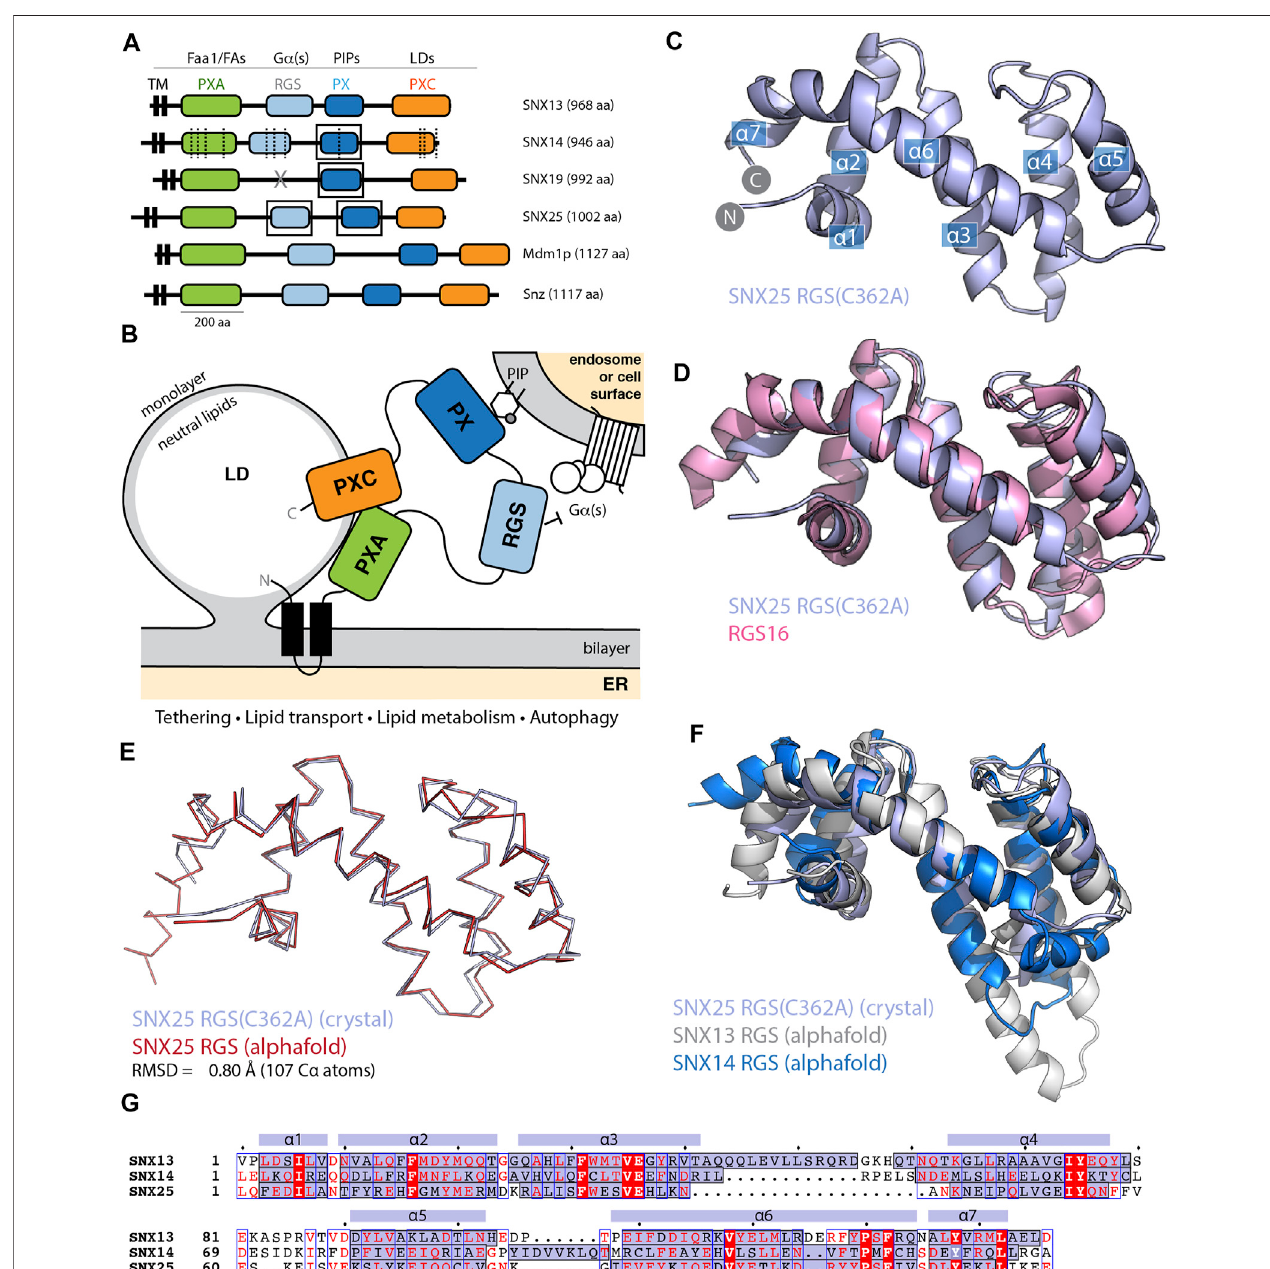
FIGURE 1 | The SNX-RGS protein family. (A) Domains of human, Drosophila , and S. cerevisiae SNX-RGS family members. Putative ligands for each domain are indicated above. SNX14 mutations causing cerebellar ataxia are shown with dashed lines (Thomas et al., 2014; Akizu et al., 2015). Boxes indicate domains with experimental structures determined. (B) The current working model for the architecture, localisation and function of the SNX-RGS protein family and their potential roles at the interface between the ER, LDs, and membranes of the endolysosomal system. (C) Crystal structure of human SNX25(C362A) RGS domain in cartoon diagram. Helical secondary structure elements are indicated. (D) The crystal structure of human SNX25(C362A) RGS domain (light blue) is aligned with the canonical RGS domain of RGS16 (pink) (PDB ID 2IK8) (Soundararajan et al., 2008) and shows the expected topology. (E) C α ribbon diagram showing the overlay of the SNX25(C362A) RGS domain (light blue) with the same sequence predicted in the AlphaFold2 database (red) (Q9H3E2). (F) Cartoon representation of SNX25(C362A) RGS domain compared with the SNX13 and SNX14 RGS domains from the AlphaFold2 database (Q9Y5W8; Q9Y5W7). (G) Sequence alignment of human SNX13, SNX14 and SNX25 RGS domains based on structural comparisons. The secondary structure of SNX25 derived from its crystal structure is shown schematically above the alignment, while the α -helical regions of the three proteins from their AlphaFold2 predictions are shaded blue within the alignment.